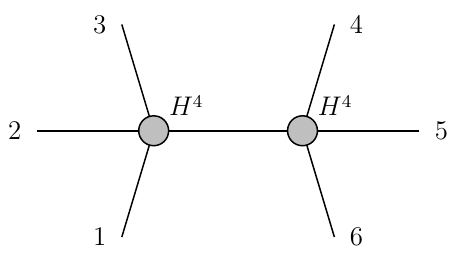
Figure 1 . Factorization of a six-point amplitude though a pair of H 4 vertices.